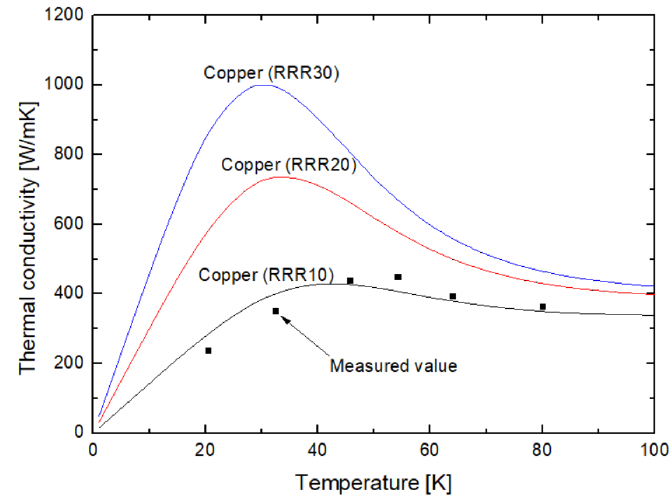
Figure 5. Thermal conductivity of copper with respect to temperature at different copper purity values. Table 2. Summary of experimental results and as compare with the design value.